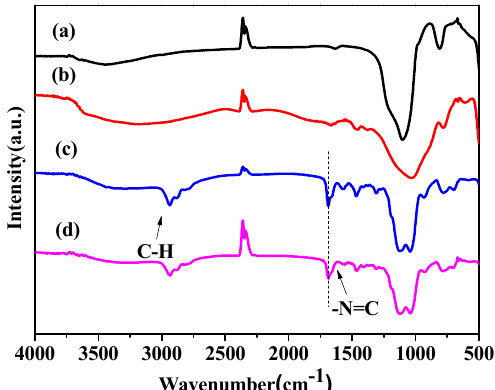
Figure 3. FT-IR spectra of Pt 0.5 /SiO 2 before ( a ) and after reaction ( b ), as well as Pt 0.5 /SiO 2 -Shiff before ( c ) and after reaction ( d ).